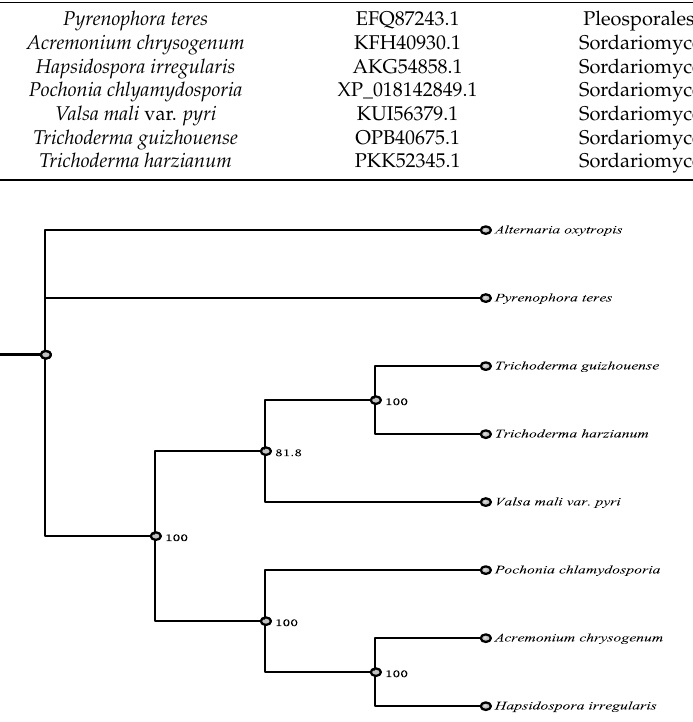
Figure 2. Maximum parsimony tree (MUSCLE alignment and 1000 replicates). Trichoderma gui- zhouense was used as the outgroup. Fungi in tree are pblast results of 21438